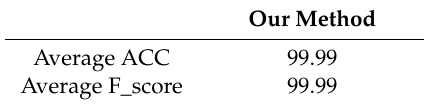
Table 8. Accuracies of recognition of arrow marking by revised CNN (unit: %).